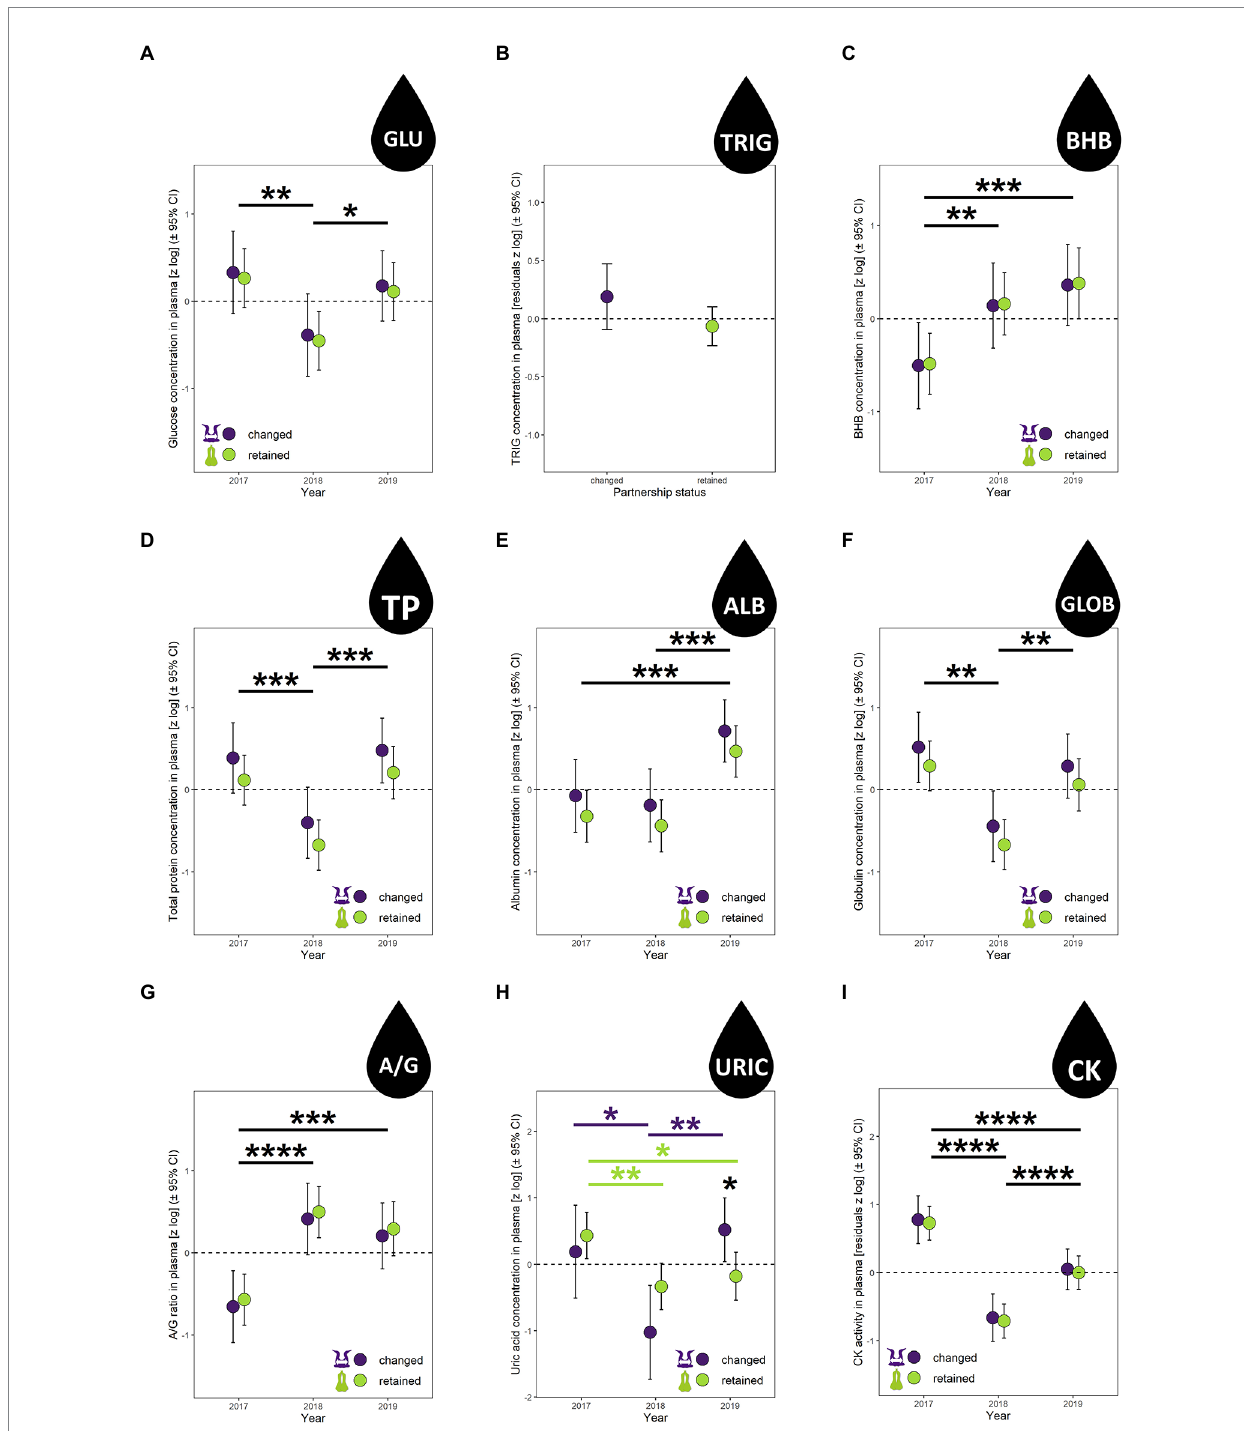
FIGURE 3 Plasma biomarkers concentration of nutritional status [ (A) glucose (GLU), (B) triglycerides (TRIG), (C) beta-hydroxybutyrate (BHB), (D) total protein content (TP), (E) albumin (ALB), (F) globulins (GLOB), (G) albumin/globulins ratio (A/G), (H) uric acid (URIC)] and muscle damage [ (I) creatine kinase activity (CK)] in northern gannets that changed and retained their mates in 2017, 2018, and 2019. Results exposed are estimated marginal means (±95% CI) by year obtained from mixed linear models build with bird ID as random parameter and these fixed parameters: partnership status for (B) , partnership status and year for (A,C,E) , partnership status, year and partnership status:year interaction for (H) , partnership status, year, sex and breeding stage for (D,F,G) , and partnership status, year and sex for (I) . Data were log-transformed and standardized (* p < 0.05, ** p < 0.01, *** p < 0.001, **** p < 0.0001; green symbols represent significant differences for individuals that retained their mate and purple symbols represent significant differences for individuals that changed